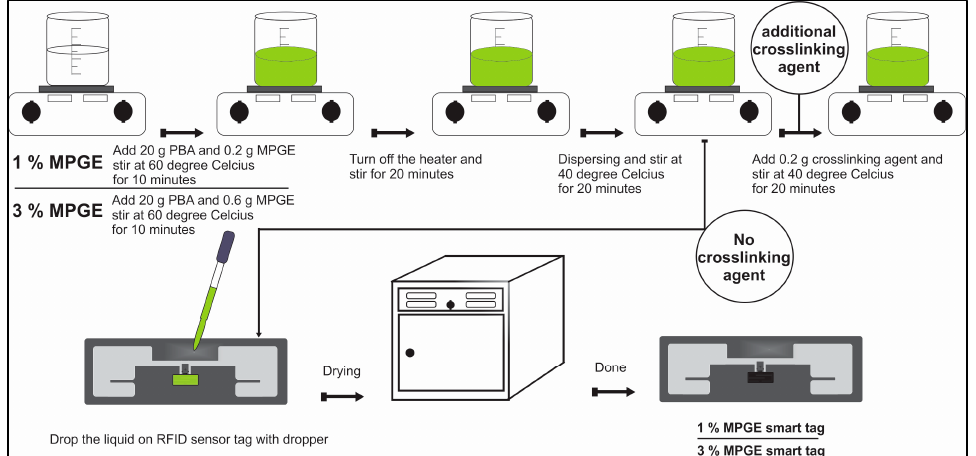
Figure 3. Schematic synthesis of MPGE smart tag with and without a crosslinking agent.